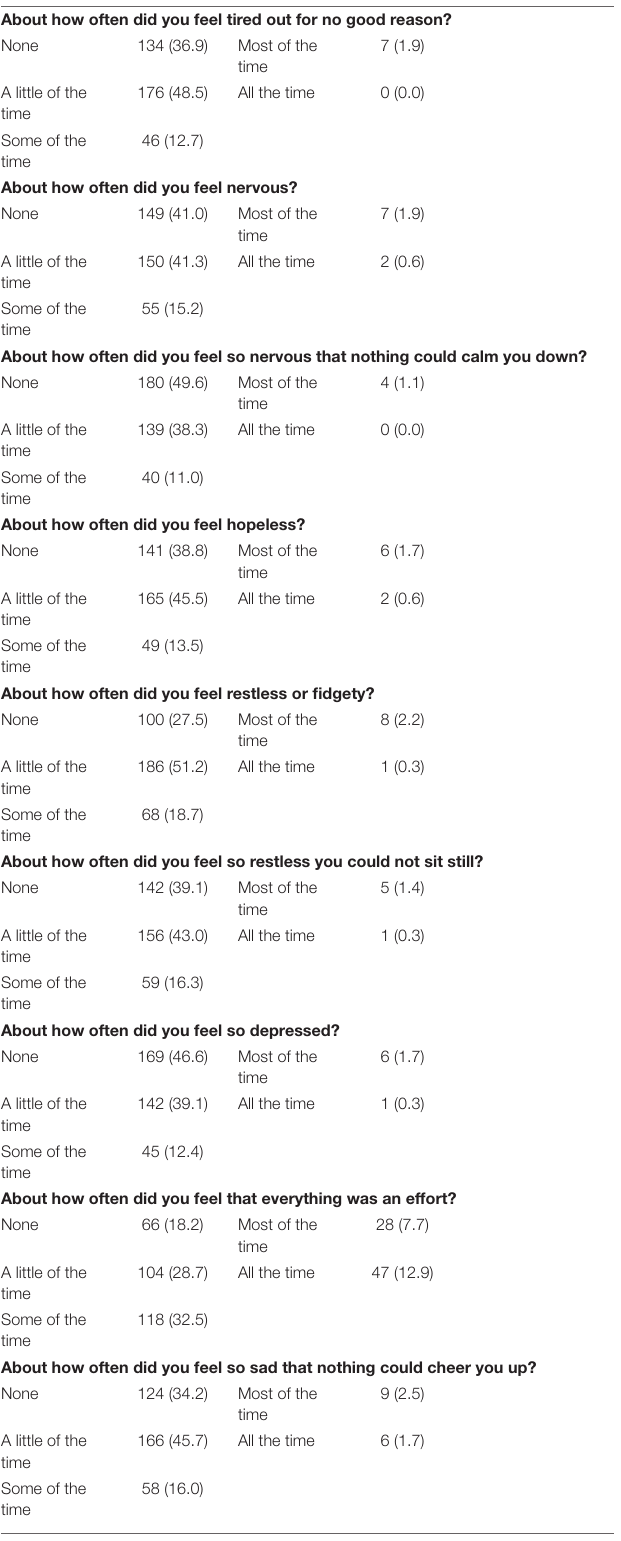
TABLE 2 | Level of psychological distress among the study participants ( n = 363). Anxiety and depression checklist (K10) (last 4